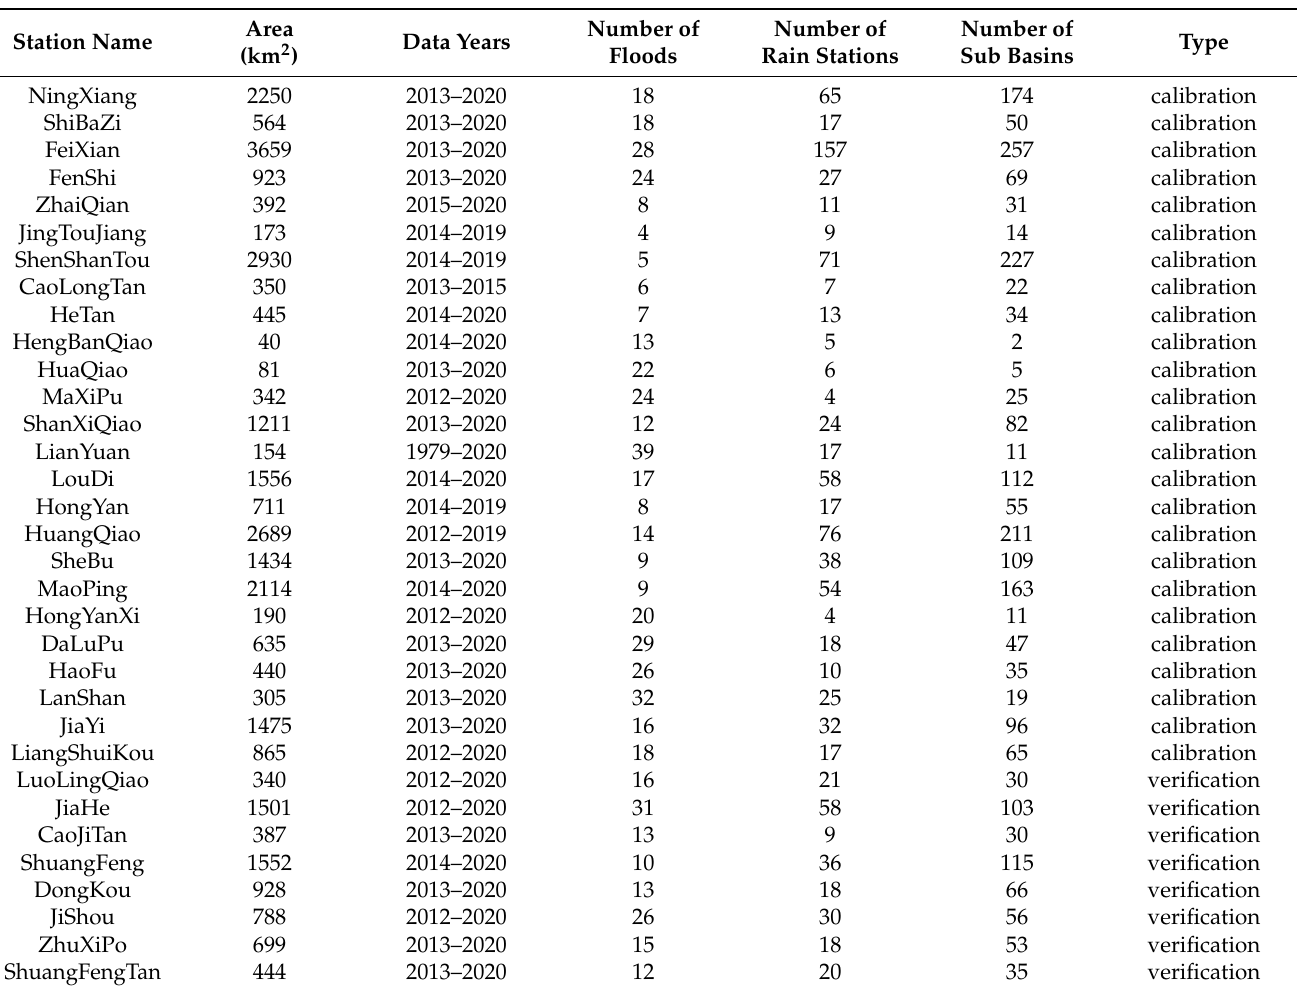
Table 1. Information of study